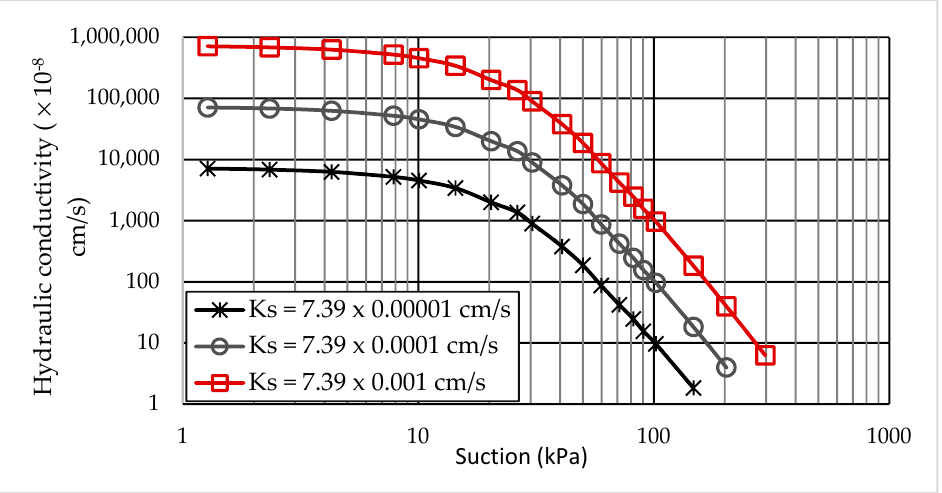
Figure 8. The different unsaturated hydraulic curves used in analyses.